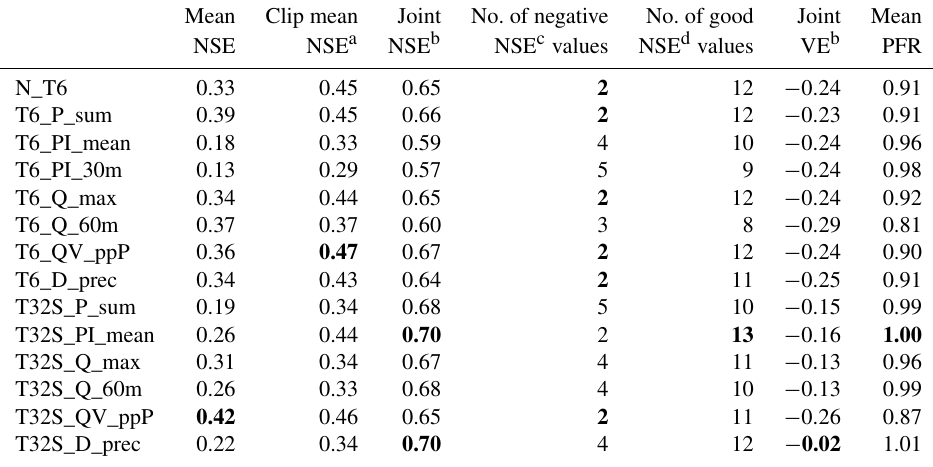
Table 6. Summarized validation performance (over 19 events) for the high-resolution model. Bold font indicates the best value in each column.